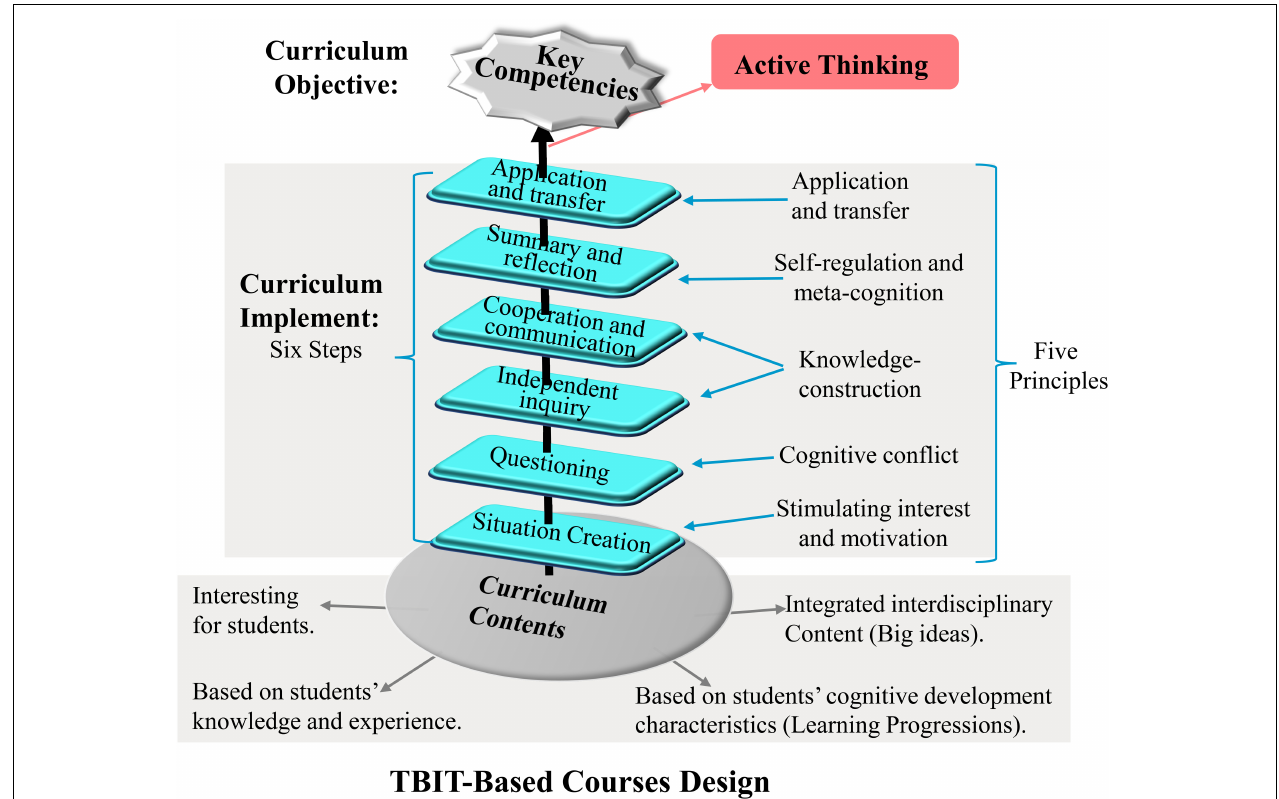
FIGURE 1 | The TBIT-based courses